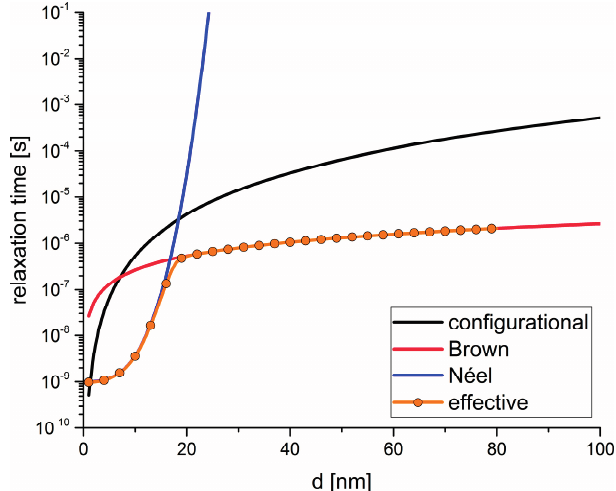
Figure 3. Relaxation times of the translational and the magnetic degrees of freedom of ensembles of magnetic cobalt particles that are immersed in an agarose matrix. The translational relaxation is dominated by the configurational relaxation time (black) whereas the magnetic relaxation can be dominated by Brownian rotation (red) or Néel rotation